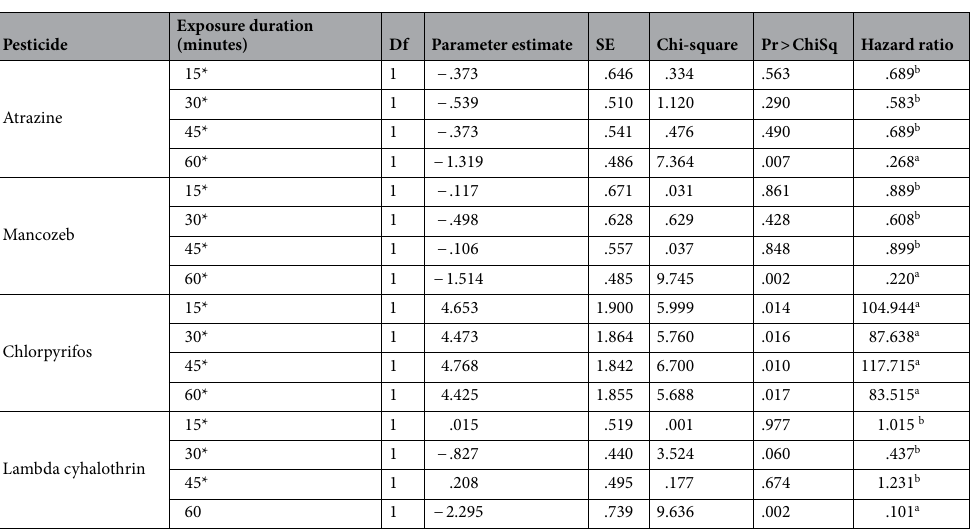
Table 4. Cox PH model summary of species effect on survival of fingerlings at different exposure duration. *Hazard ratio constant with time. a Statistical significant ( p < 0.05). b Not significant ( p >